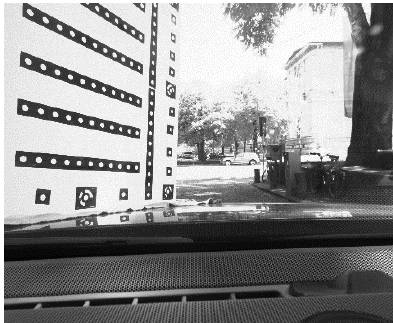
Figure 4. Image of the left industrial camera showing the calibration pattern through the windshield of the car. For the separate image processing of both cases, the image coordinates of the calibration marks are measured. The 2d image coordinates of the marks are co-registered with the 3d object coordinates of the calibration pattern. Several iterations of the Figure 2. Rigid stereo cameras looking nearly parallel through bundle adjustment are performed until the adjustment converges. the curved windshield of a car. Curvature of windshield along and across the driving direction can be seen.